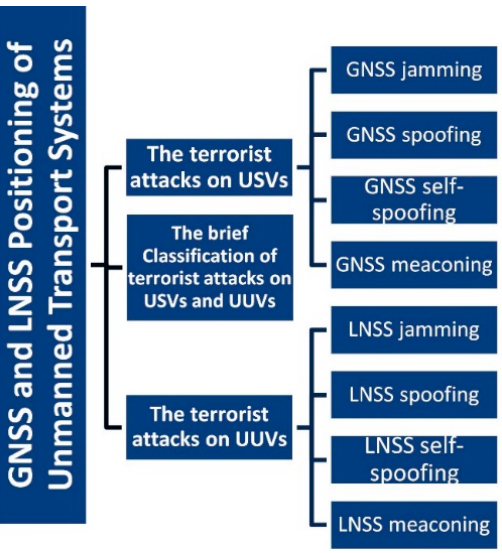
Figure 15. The classification of terrorist attacks on USVs and UUVs.